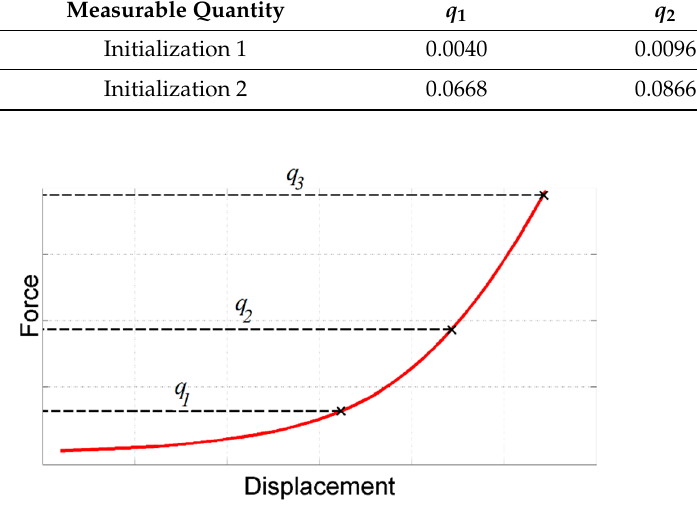
Figure 5. Measurable quantities selected for sensitivity analysis.